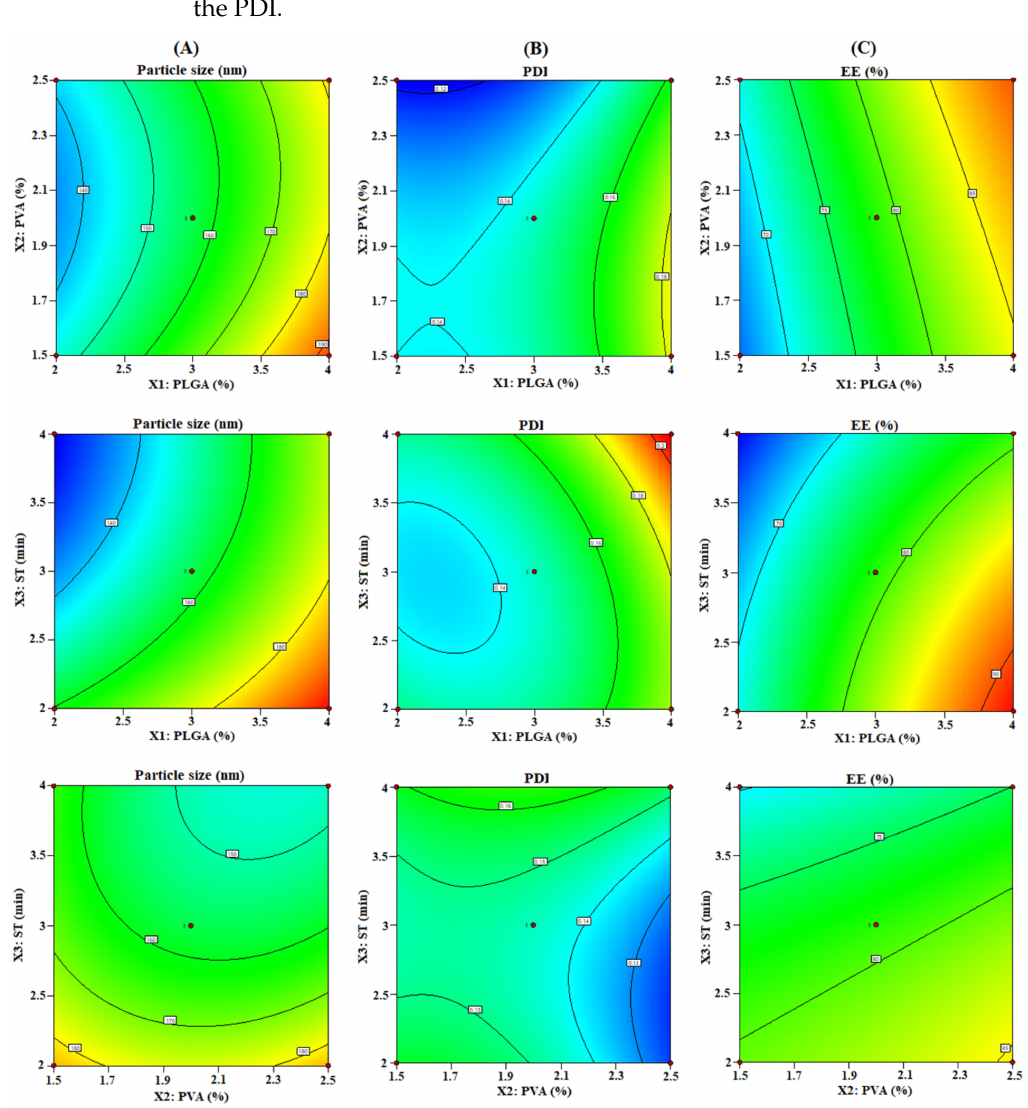
Figure 2. Contour response surface plots showing the influence of PLGA ( X 1 ), PVA ( X 2 ), and ST ( X 3 ) on response parameters: ( A ) PS ( Y 1 ), ( B ) PDI ( Y 2 ), and ( C ) EE ( Y 3 ) of